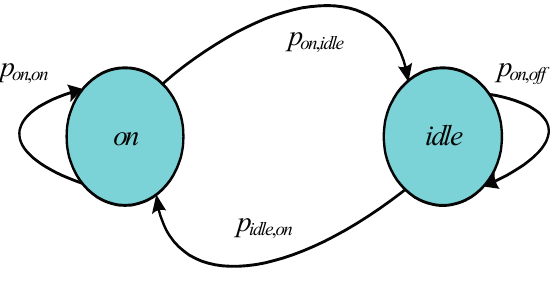
Figure 5. State diagram of the power model.